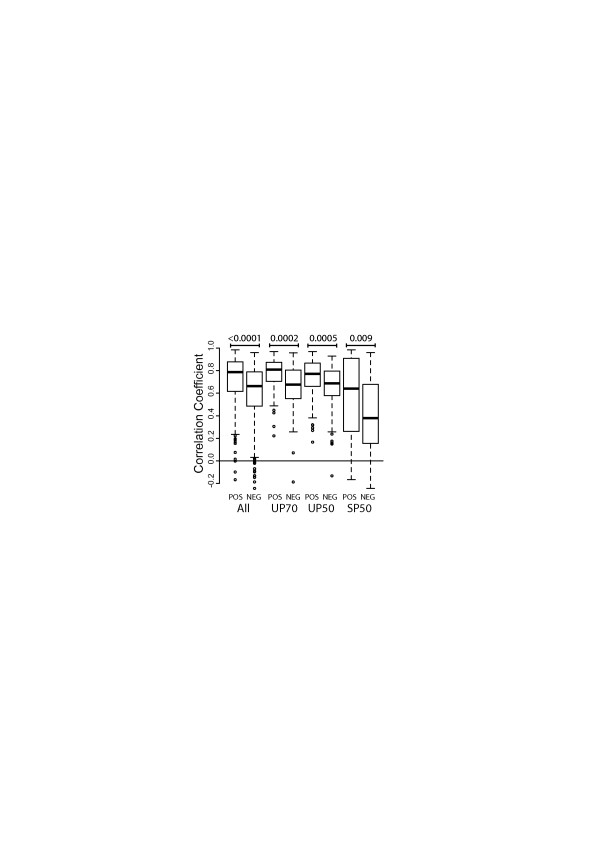
Correlation of genetic distance matrices. This figure shows the box-plot distribution of Pearson’s correlation coefficient for the genetic distance matrices of a pair of proteins for the different datasets. Heavy bars represent mean values, boxes indicate 25 and 75 percentiles and bars indicate 5 and 95 percentiles. POS indicates interacting proteins, and NEG indicates non-interacting proteins. P-values of the Mann–Whitney tests comparing the distributions of interacting and non-interacting protein datasets are indicated for each pair.